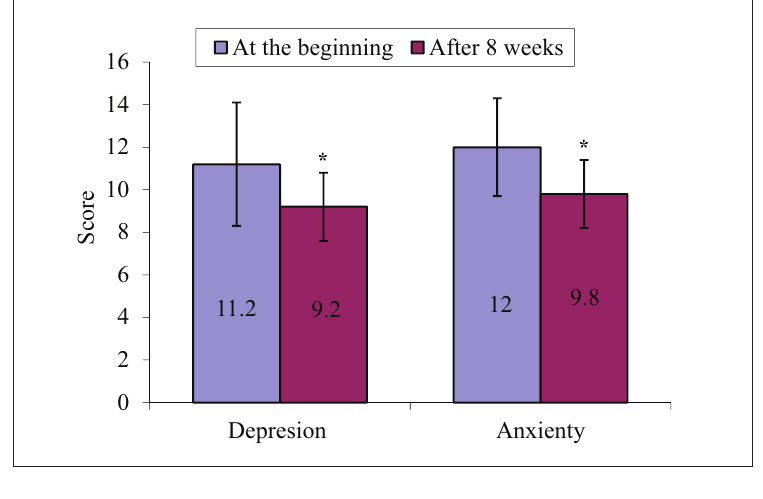
Figure 1. Depression and anxiety symptoms in the experimental group at the beginning and after an 8-week strength training program